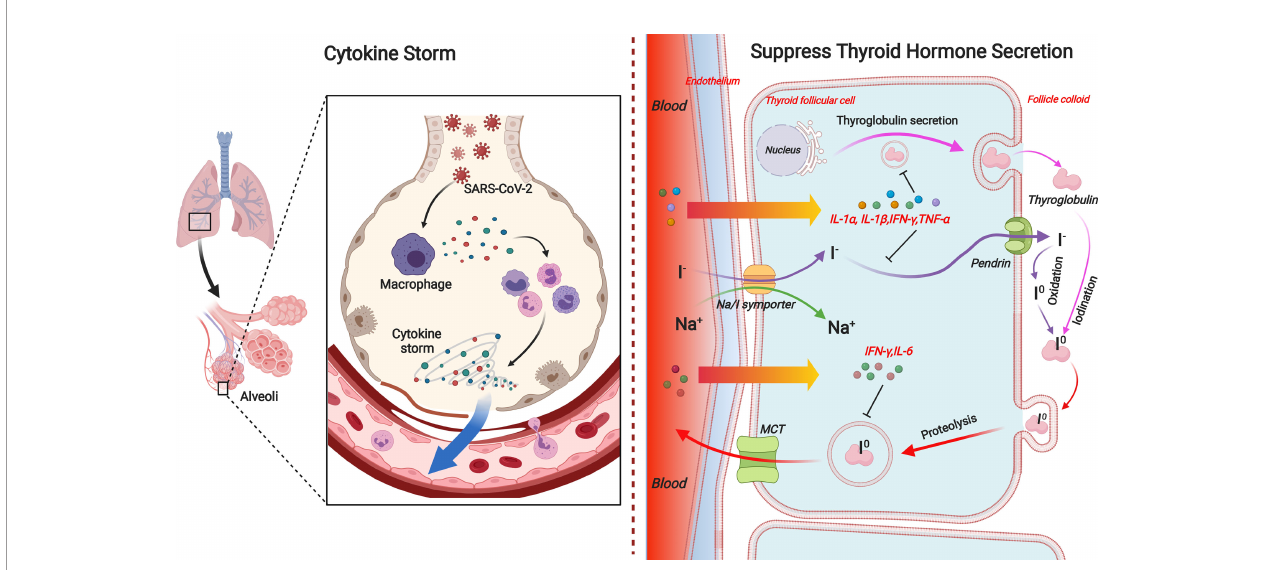
FIGURE 1 | Overview of indirect effects of SARS-CoV-2 on thyroid hormone level in pregnant women. SARS-CoV-2 infection can promote disarrangement of thyroid hormone in pregnant women directly through thyroid gland damage or indirectly through in fl ammation-induced suppression in diverse links of hypothalamic – pituitary – thyroid axis. Acute in fl ammation caused by coronavirus infection can respectively reduce TRH and TSH production or release. Pro-in fl ammatory cytokines, especially IL-1 a , IL-1 b , IL-6, IFN- g , and TNF- a , are responsible for diminished iodide uptake, TH secretion, or Tg production by means of individual or collaborative style. On the other hand, the expression and activity of deiodinases in tissues, i.e., D1 and D3 are directly suppressed or inactivated by in fl ammation or illness. TRH, thyrotropin-releasing hormone; TSH, thyroid-stimulating hormone; TH, thyroid hormone; D1, deiodinase 1; D3, deiodinase